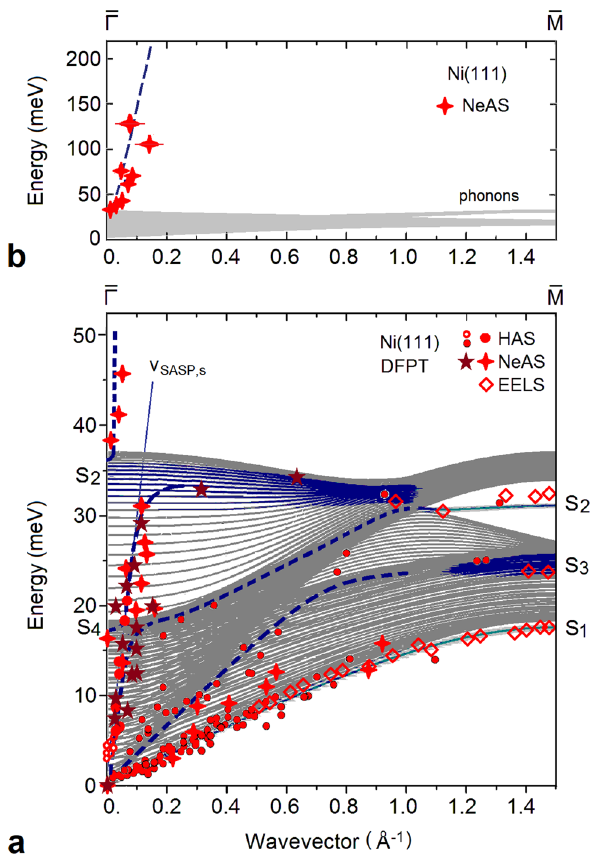
Figure 3. ( a ) The set of inelastic scattering data from HAS (full and empty circles), NeAS (five-stars: present; crosses: Refs. 20 and 34 ) and EELS (empty lozenges 35 ) in the low energy region, superimposed to the DFPT calculation of Ni(111) dispersion curves (full lines: surface phonons with S 1 the Rayleigh wave, S 2 the optical Wallis mode and S 4 the sagittal Lucas mode; blue area: surface phonon resonances, with S 3 the longitudinal acoustic surface resonance; broken lines are eye guidelines showing the possible SASP-surface phonon avoided crossings and the SASP velocity v SASP,s in the phonon region). ( b ) NeAS data points above the phonon maximum from Refs. 20,29 , with the broken line indicating the Fermi velocity of the Ni(111) majority-spin surface